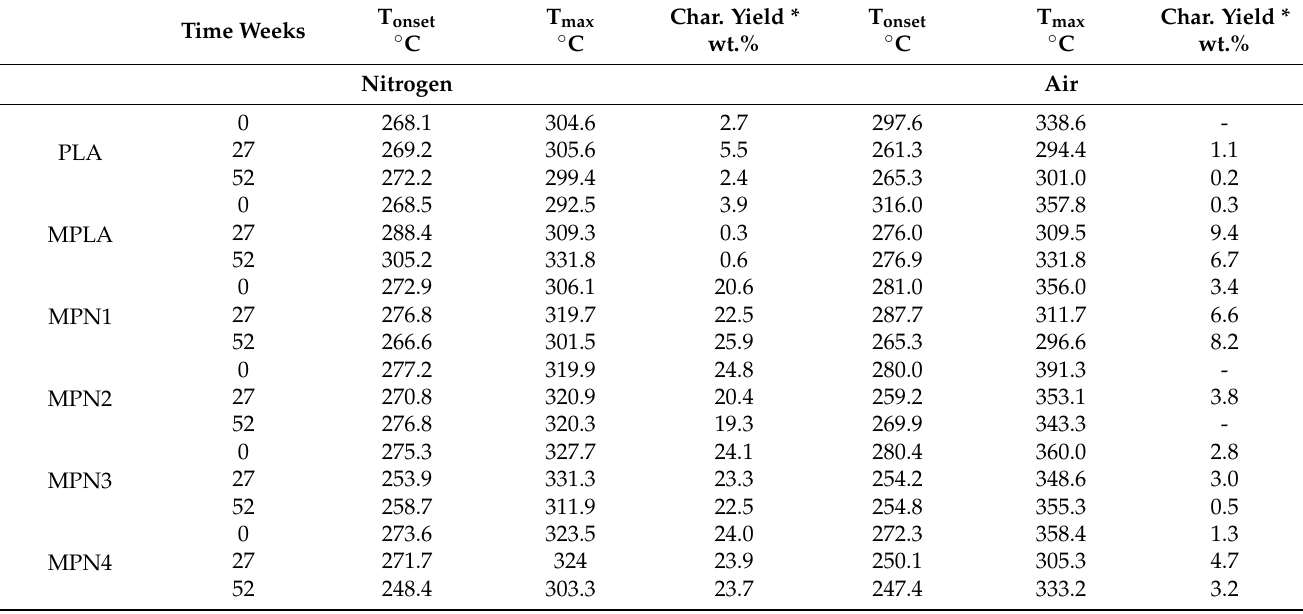
Table 6. TGA data of MPLA biocomposites at various times of biodegradation in soil under nitrogen and air